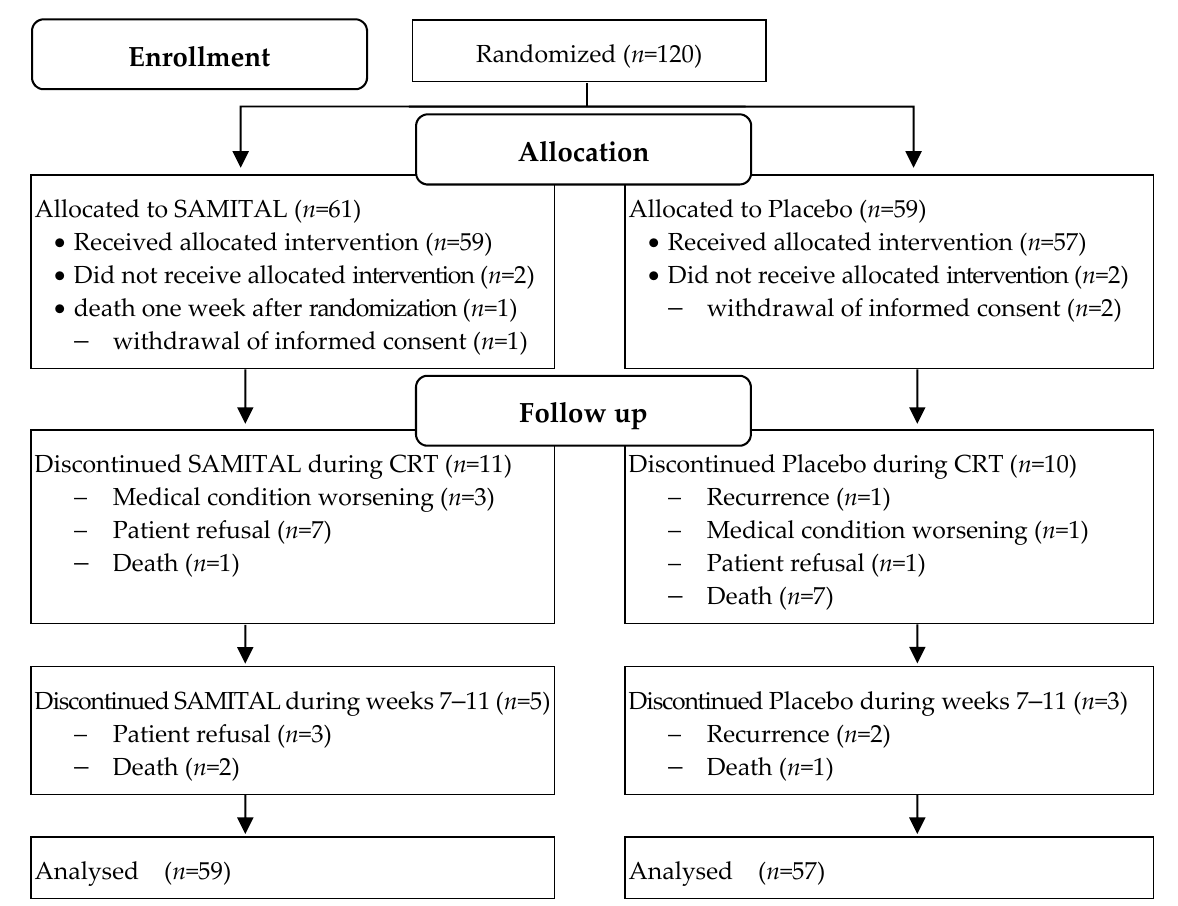
Figure 1. Trial flow chart.